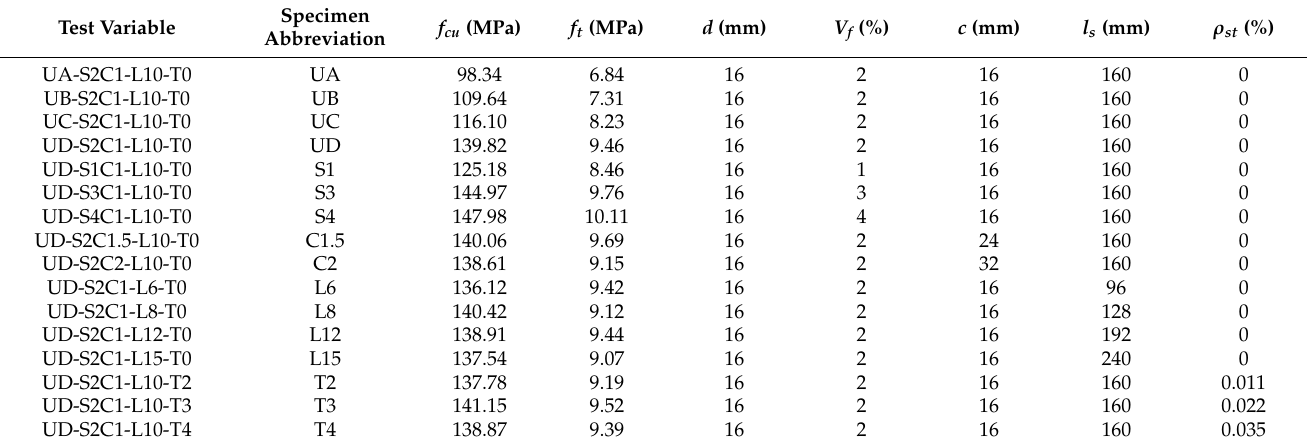
Figure 2. Geometric dimensions and reinforcement details of specimens (unit: mm).